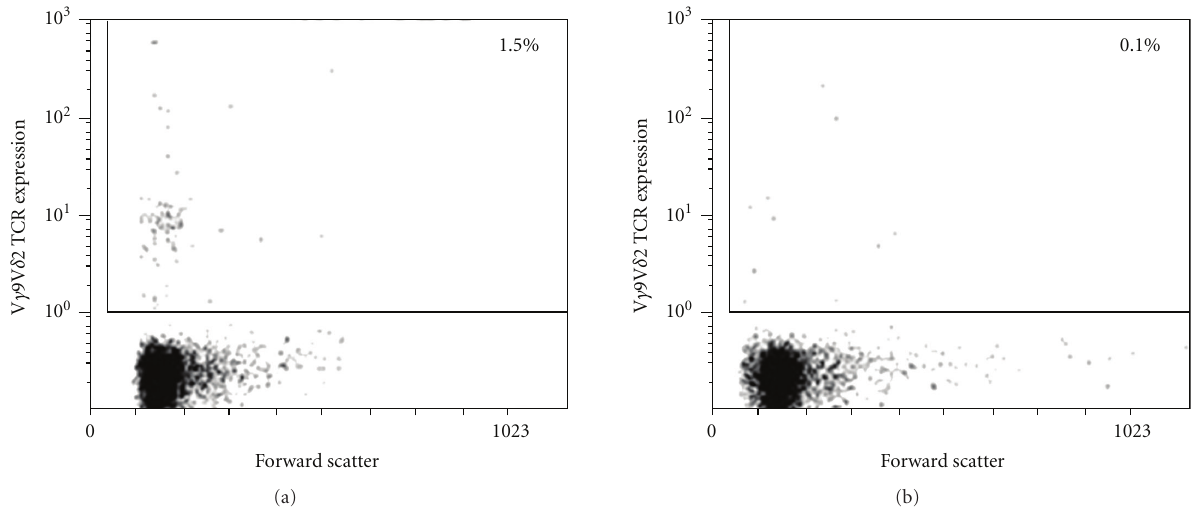
Figure 1: Flow cytometry plot showing a representative population of γδ T cells present in human PBMCs. Before depletion by magnetic bead separation, γδ T cells constituted ∼ 1.5% of PBMC (a) and < 0.1% after depletion